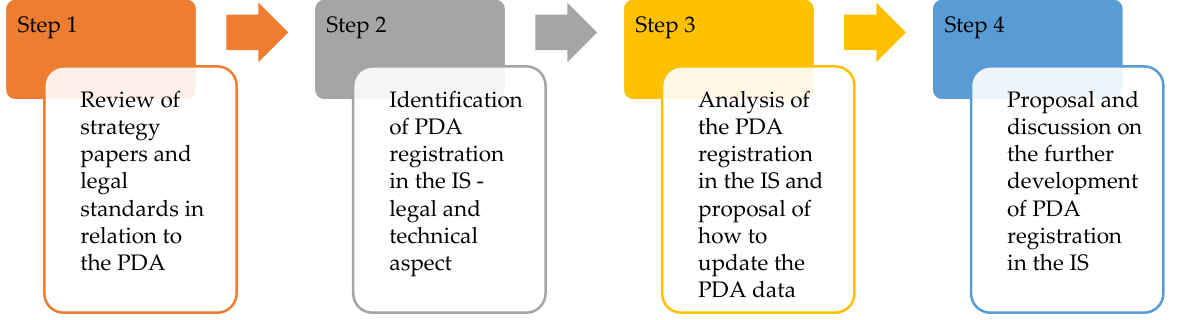
Figure 1. The methodology